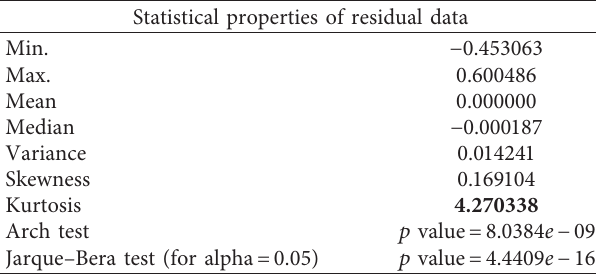
Table 8: Statistical properties of residual data.